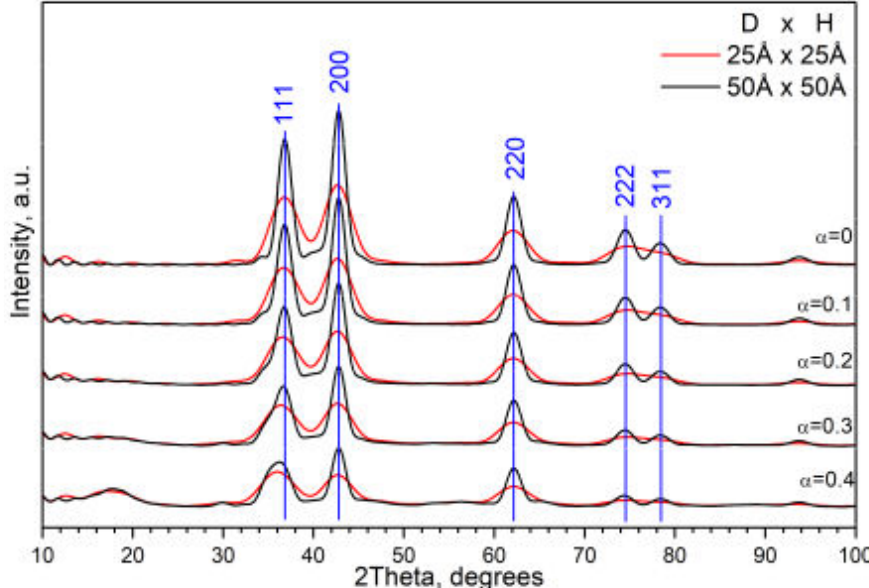
Figure 7. XRD patterns calculated for the statistical model consisting of Ni 4 O 4 and Si 2 O 4 layers with different fractions ( α ) of Si 2 O 4 layers. Calculations were carried out for cylindrical particles consisting of N = 10 layers (height of the particle H ~ 25 Å) with the diameter D ~ 25 Å and N = 20 layers (H ~ 50 Å) with D ~ 50 Å. Blue lines show Bragg positions for the 111, 200, 220, 331, and 222 peaks for